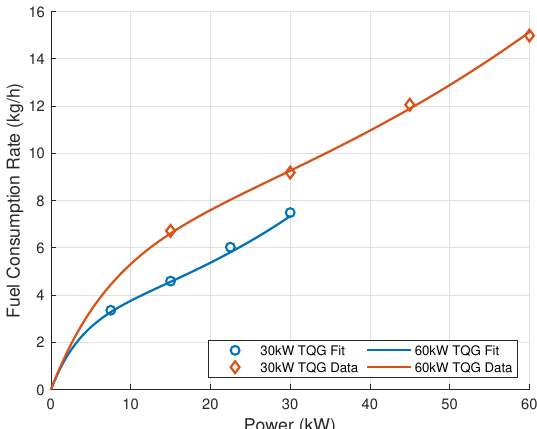
Figure 1. The fuel flow rate versus power curves for the 30 kW and 60 kW TQGs using Equation (2) with the parameters of Table